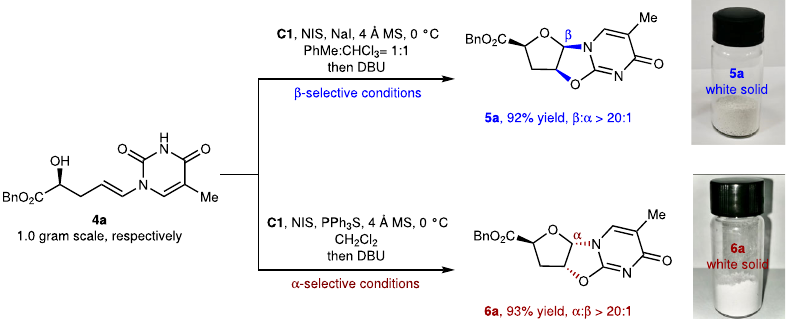
Fig. 4 | Gram-scale synthesis. β -Nucleoside analog 5a and α -nucleoside analog 6a were synthesized at gram scale from 4a with high yields and high stereoselectivities.